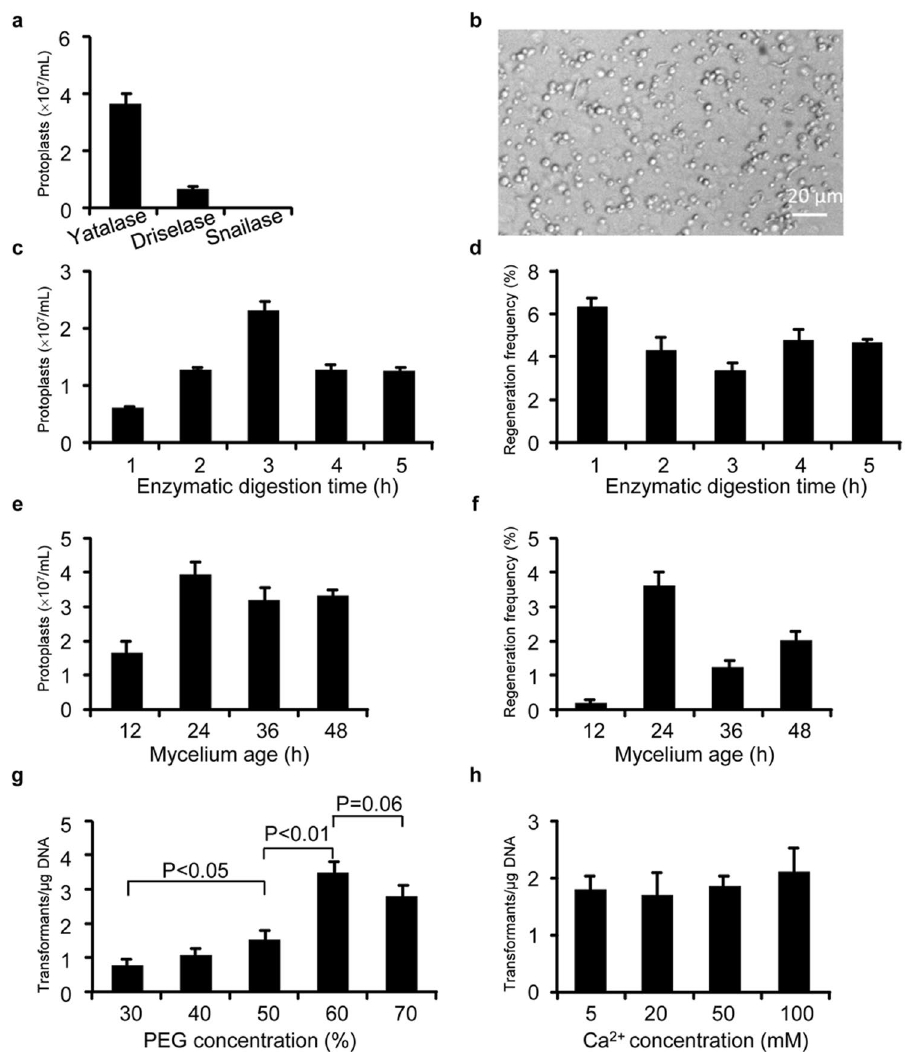
Figure 1. Protoplast preparation and transformation for Nodulisporium sp. (No. 65-12-7-1). ( a ) The amount of protoplasts produced by treatment of the mycelia of Nodulisporium sp. (No. 65-12-7-1) with 3 different enzymes: Yatalase (10 mg/mL), Driselase (10 mg/mL) and Snailase (10 mg/mL). ( b ) Microscopic check of protoplasts released from the mycelium of Nodulisporium sp. (No. 65-12-7-1). ( c ) The amount of protoplasts produced by Yatalase treatment for different incubation time. ( d ) The regeneration frequency of protoplasts produced by Yatalase treatment for different incubation time. ( e ) The amount of protoplasts produced from the mycelia of different age. ( f ) The regeneration frequency of protoplast produced from the mycelia of different age. ( g ) The transformation efficiency under different concentrations of PEG. Student’s t-test was performed for comparing the transformation efficiency under different concentrations of PEG. ( h ) The transformation efficiency under different concentrations of Ca 2 + . All values are means ± standard error of the mean from three independent